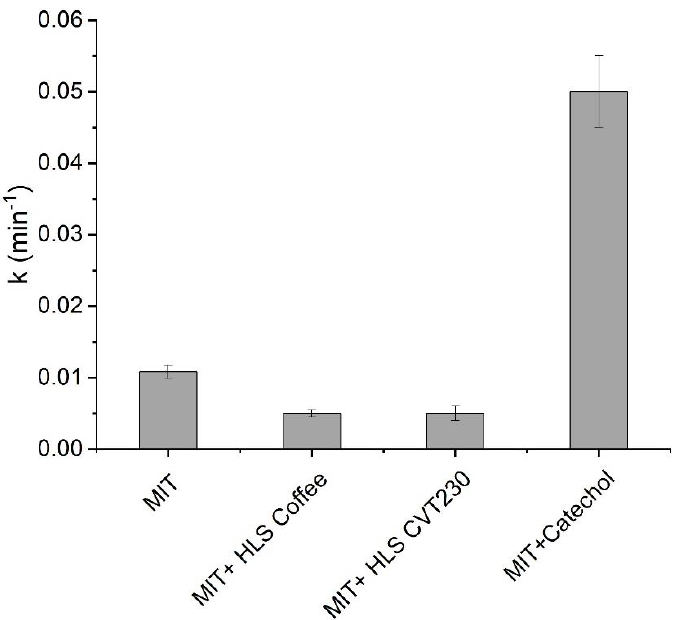
Figure 4. Effect of different complexing agents on the kinetics of MIT degradation at pH 5. [MIT] = 5 mg·L −1 , [H 2 O 2 ] = 5mg·L −1 (stoichiometric), [Fe (III)] = 5 mg·L −1 , [HLS Coffee] = 25 mg·L −1 , [HLS CVT230] = 25 mg·L −1 , [Catechol] = 25 mg·L −1 .